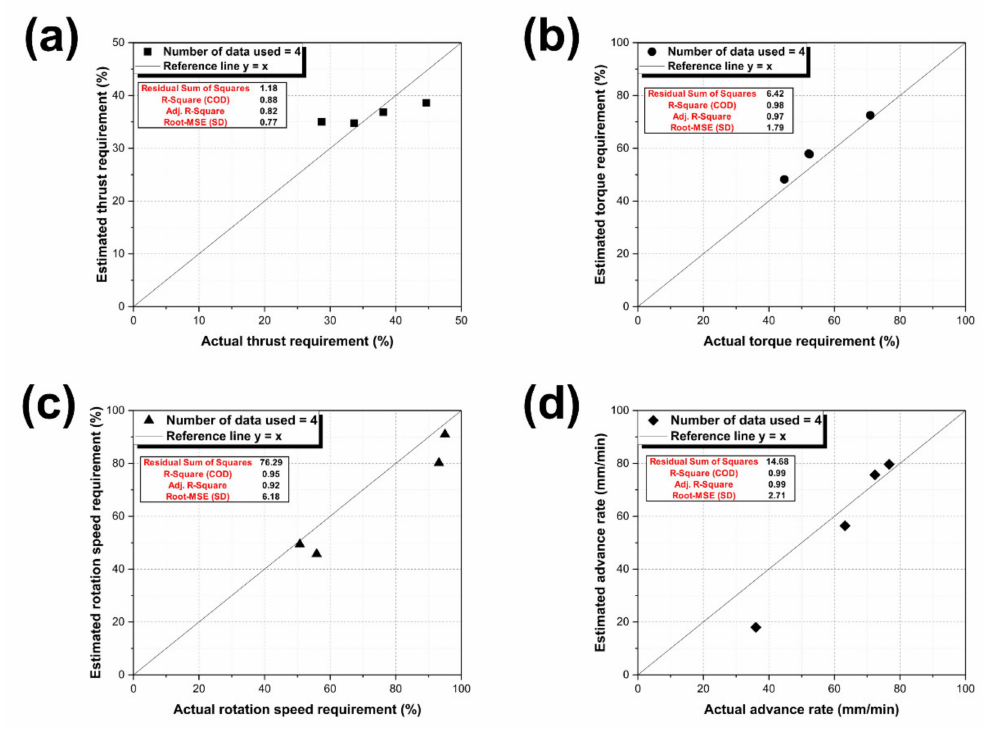
Figure 3. Verification of regression equations for soil excavation. Estimations of the required ( a ) thrust, ( b ) cutterhead torque, ( c ) rotation speed, and ( d ) advance